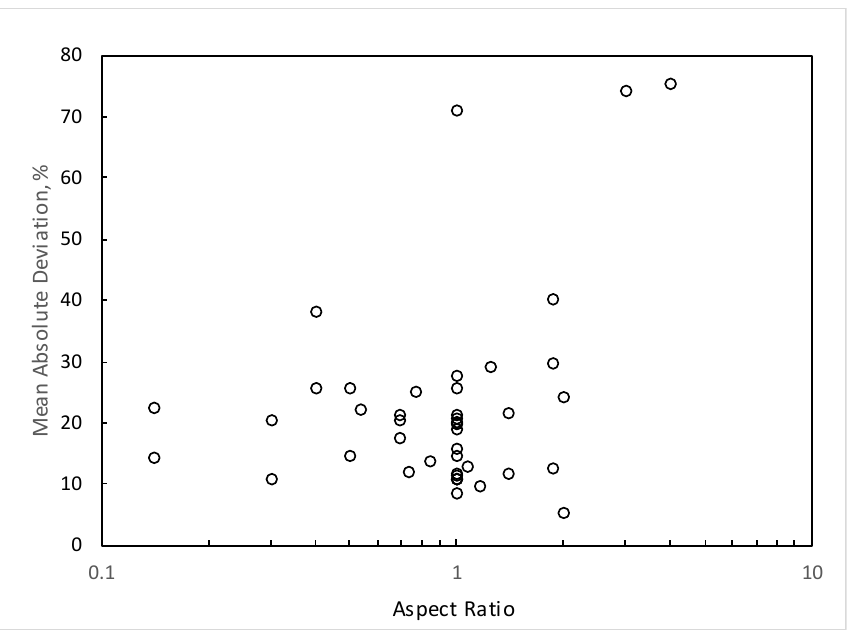
Figure 2. Mean absolute deviations of data sets with Shah [3] correlation vs aspect ratio of channels other than flattened tubes.